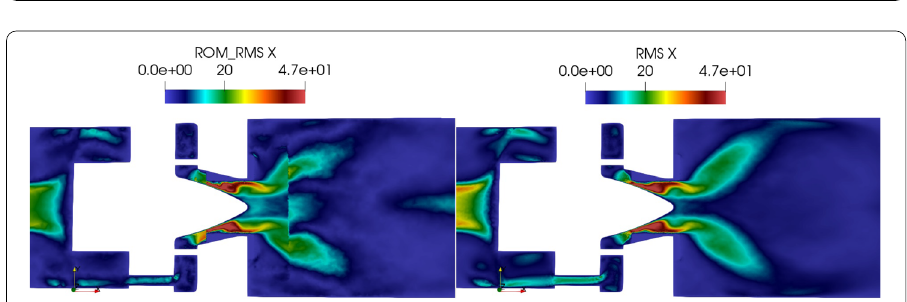
Fig. 50 Smaller RFD. On the left, the first component of the root mean square flow field by the UGPOD applied to configuration 1. On the right, the first component of the high fidelity root mean square flow field with configuration